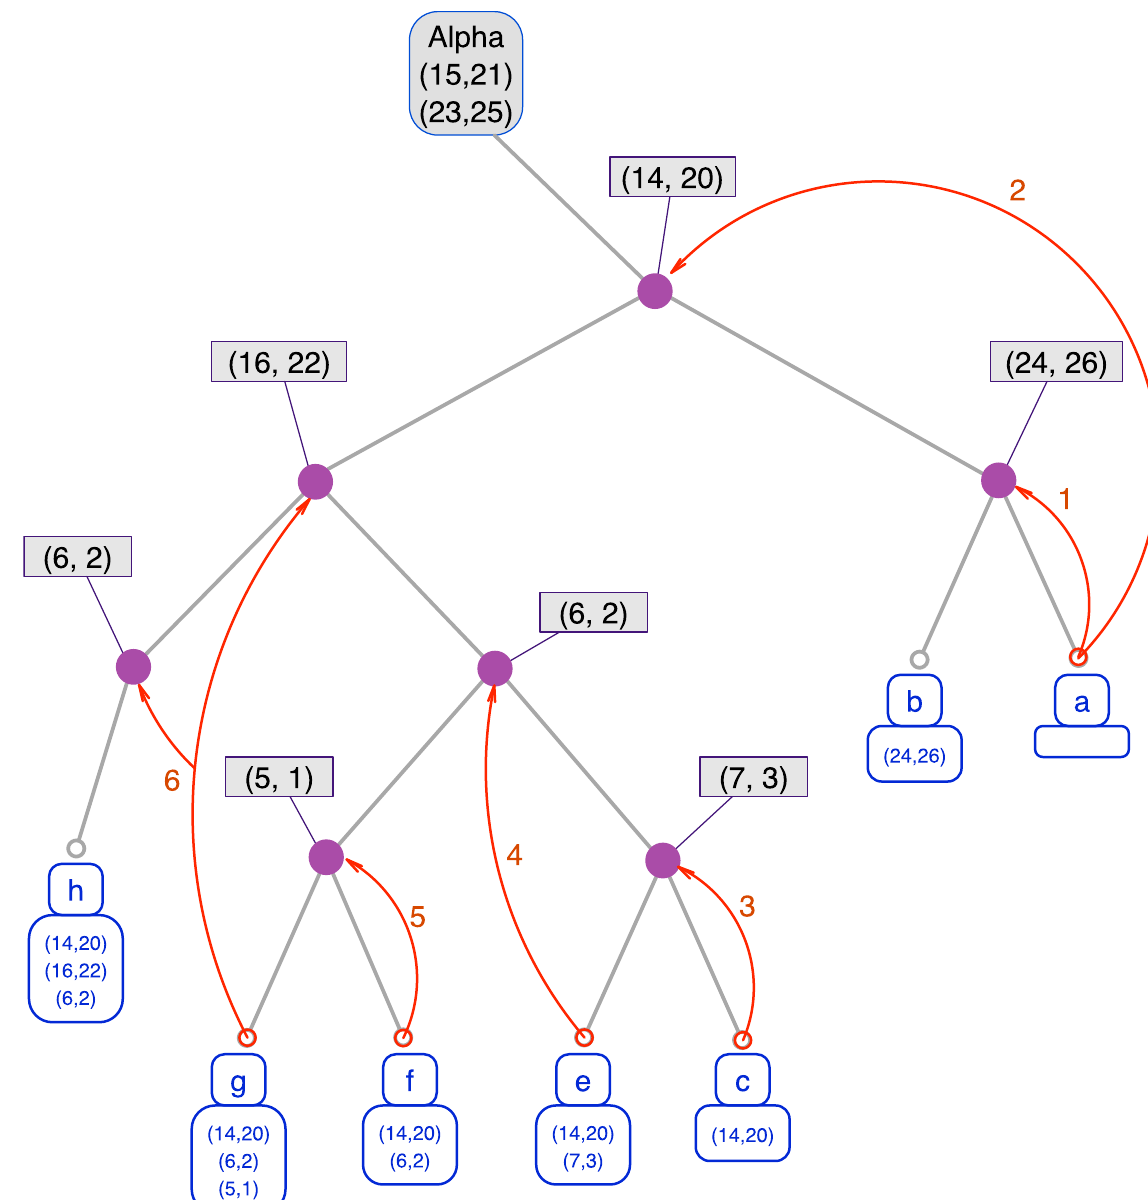
Fig 5. Exploration tree with backtracking. This figure displays the exploration tree representing a posteriori the relation between the different branches created. In this tree, the root is a starting point (i.e. the nodes that are already matched at the start of an exploration) and each leaf is a different maximal common subgraph. Each path from the root to a leaf describes an exploration. For instance, the node (14,20) of the exploration tree corresponds to the action of matching the node 14 from G to the node 20 of H. All the leafs in the right subtree have matched 14 to 20 and all the ones in the left subtree have not. Note that only the nodes with a left child are represented, all other nodes have been collapsed since they bear no information about the exploration process. The first exploration always produces the right most maximal common subgraph. In this exemple, the first exploration encountered two conflicts and the algorithm thus produced two new branches which respectively were instructed not to add (24,26) and not to add (14,20). The first of the two produced another maximal common subgraph without any trouble but the second encountered another conflict and so on and so